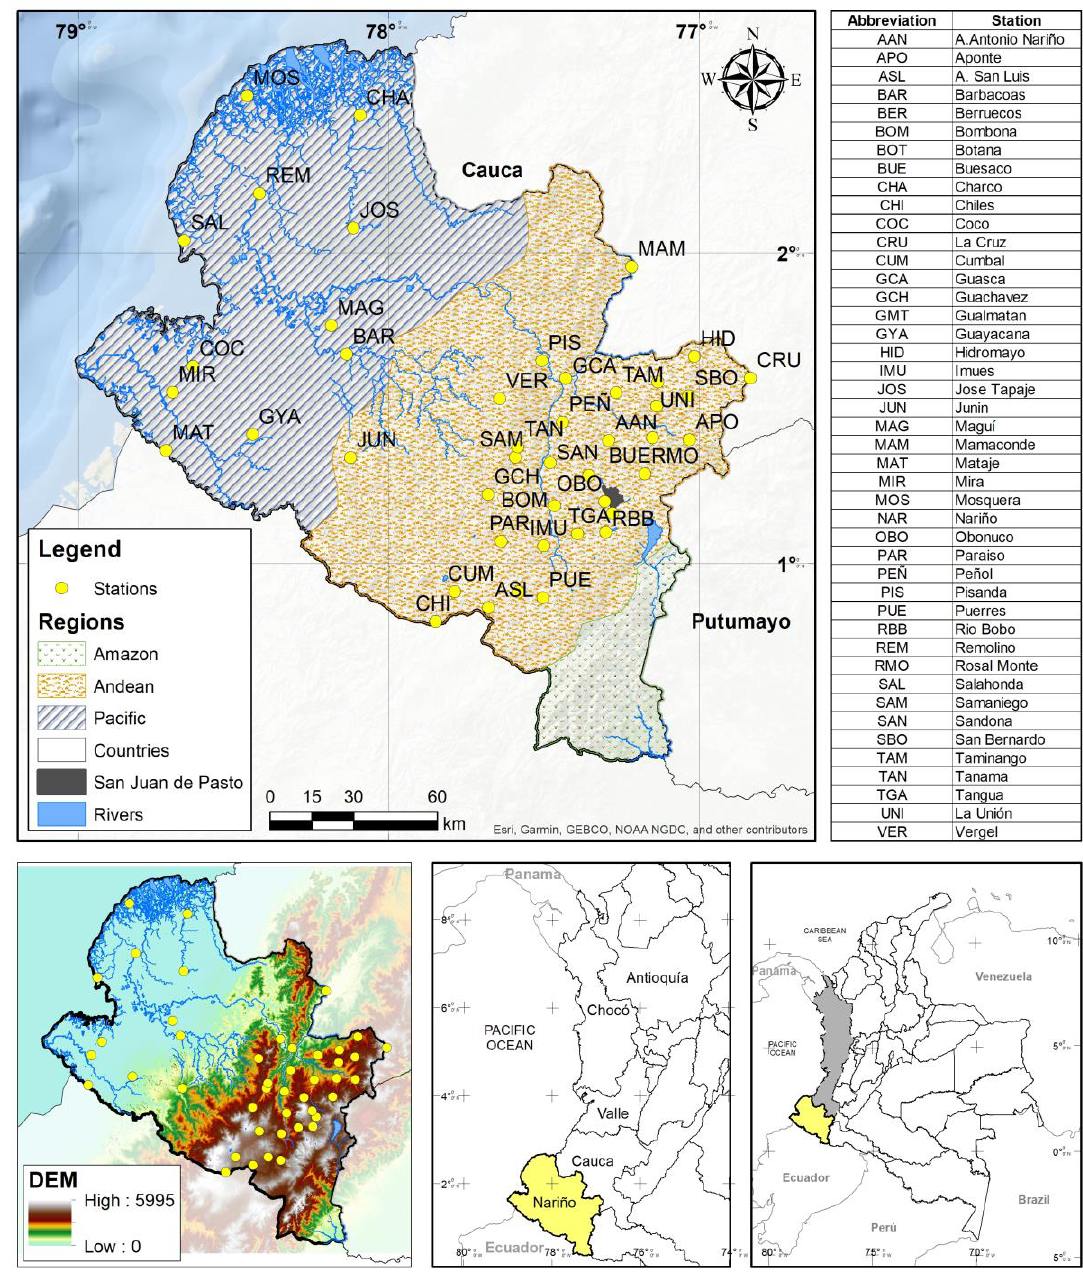
Figure 1. The geographic location of the study area and the distribution of the rainfall gauge stations.